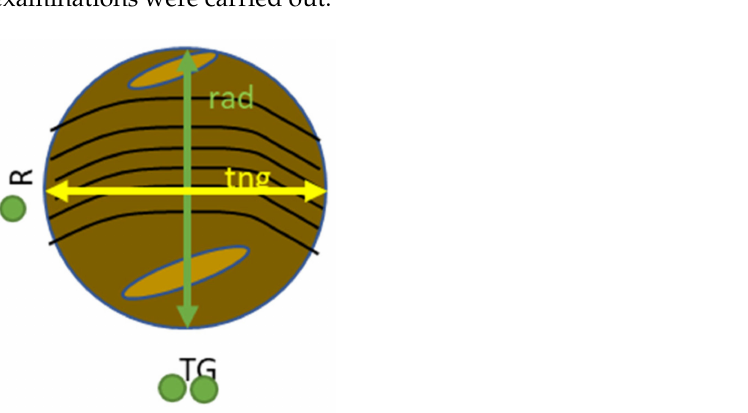
Figure 13. Directions of roughness measurement on the pin-on-disc test pin